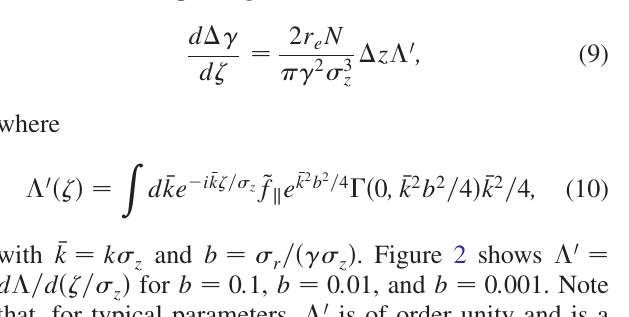
FIG. 1. Functional dependence of I ¼